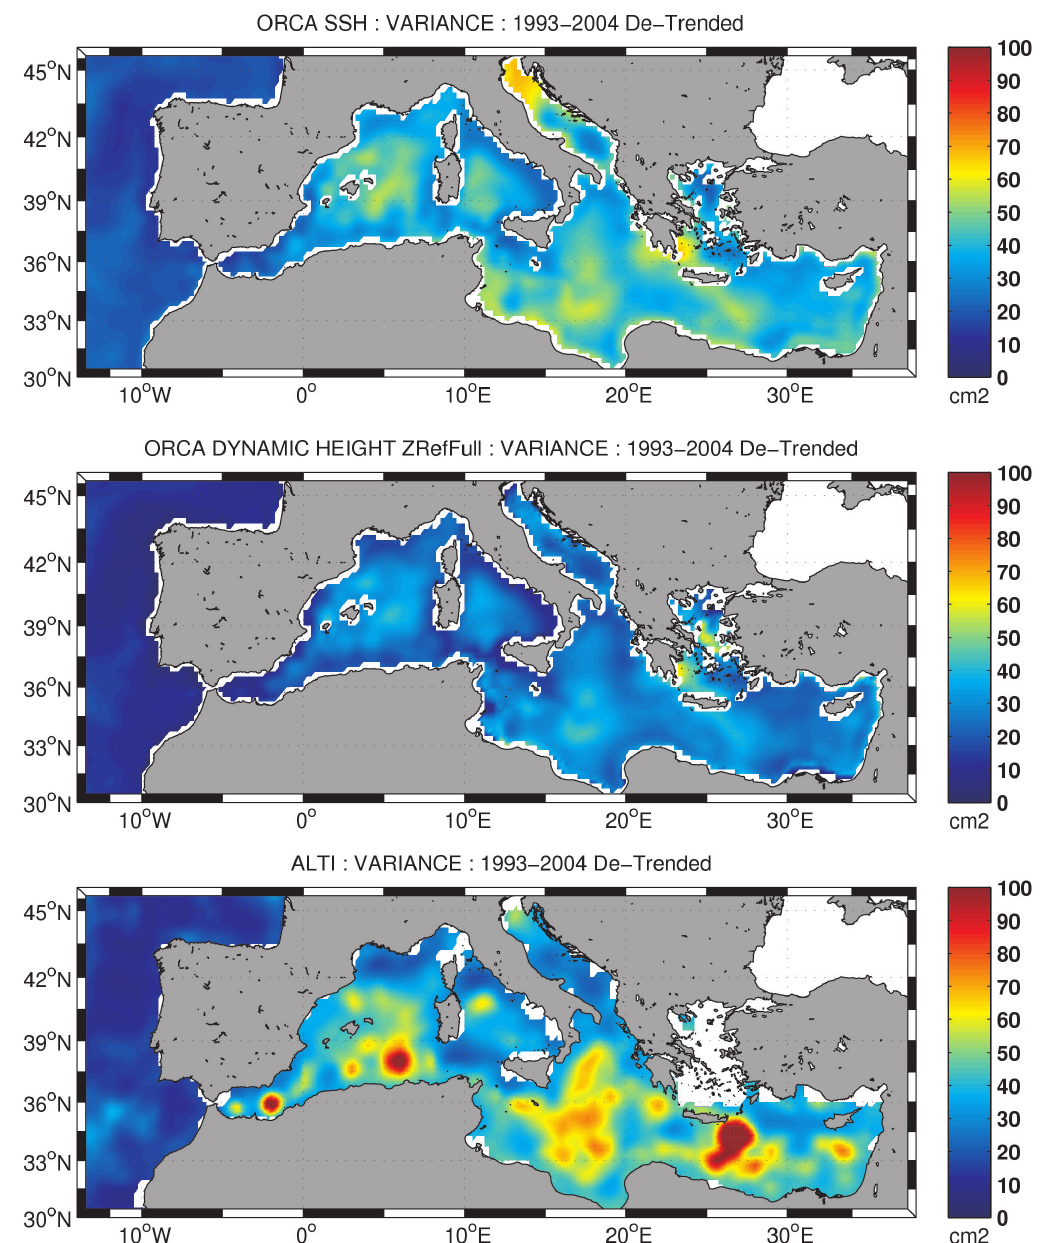
Fig . 8. – ORCA steric height (top), ORCA sea surface height (middle) and altimetry (bottom) de-trended variance maps for the 1993-2004